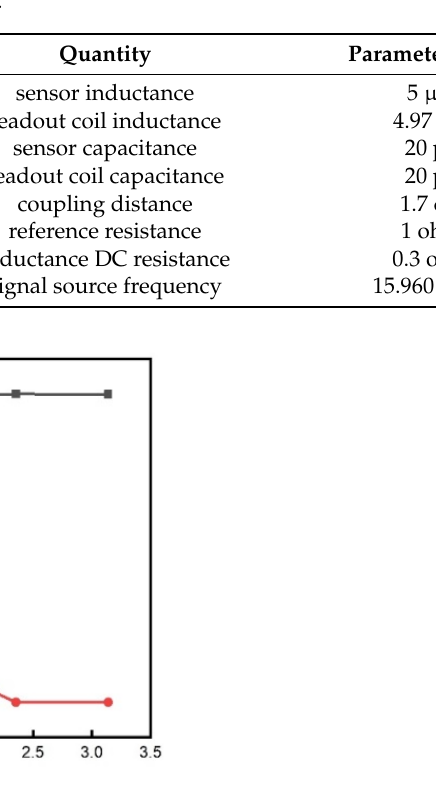
Figure 3. Simulated impedance phase as a function of rotation angle without a matching capacitor (black line) and with a matching capacitor (red line).